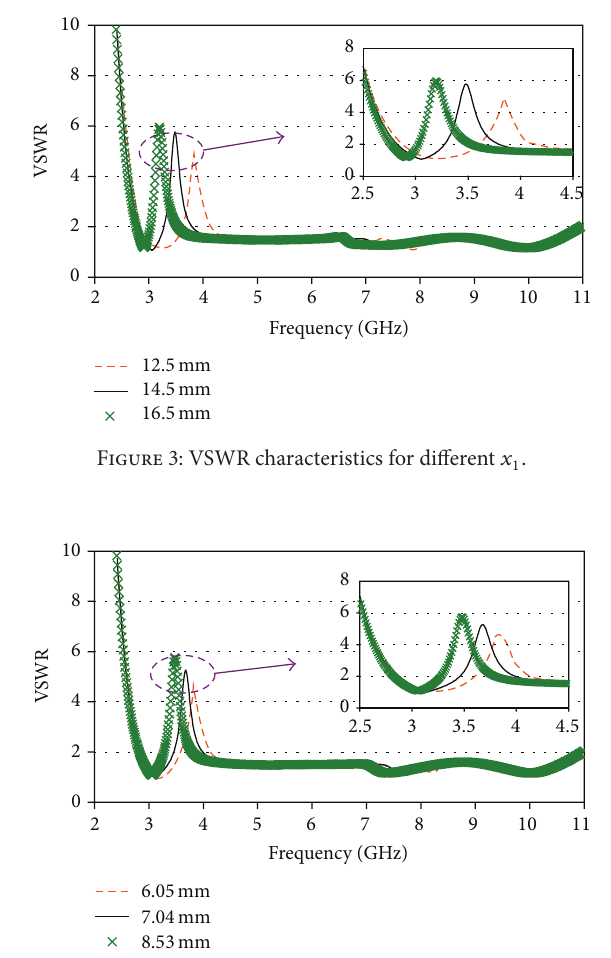
Figure 4: VSWR characteristics for different 𝑥 2 .